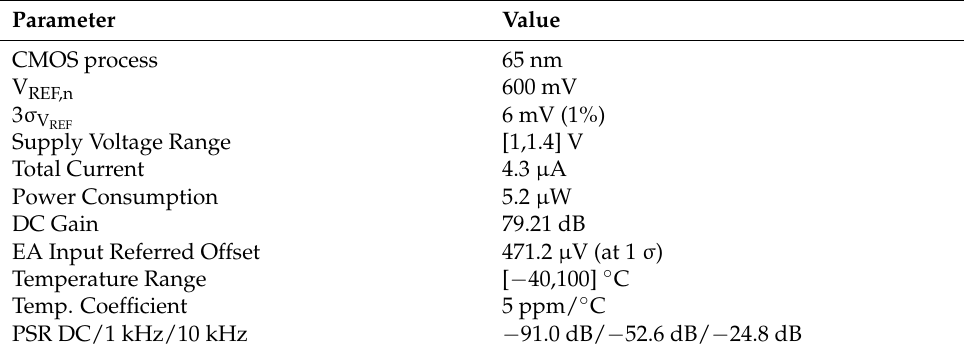
Table 2. Simulated performance of this